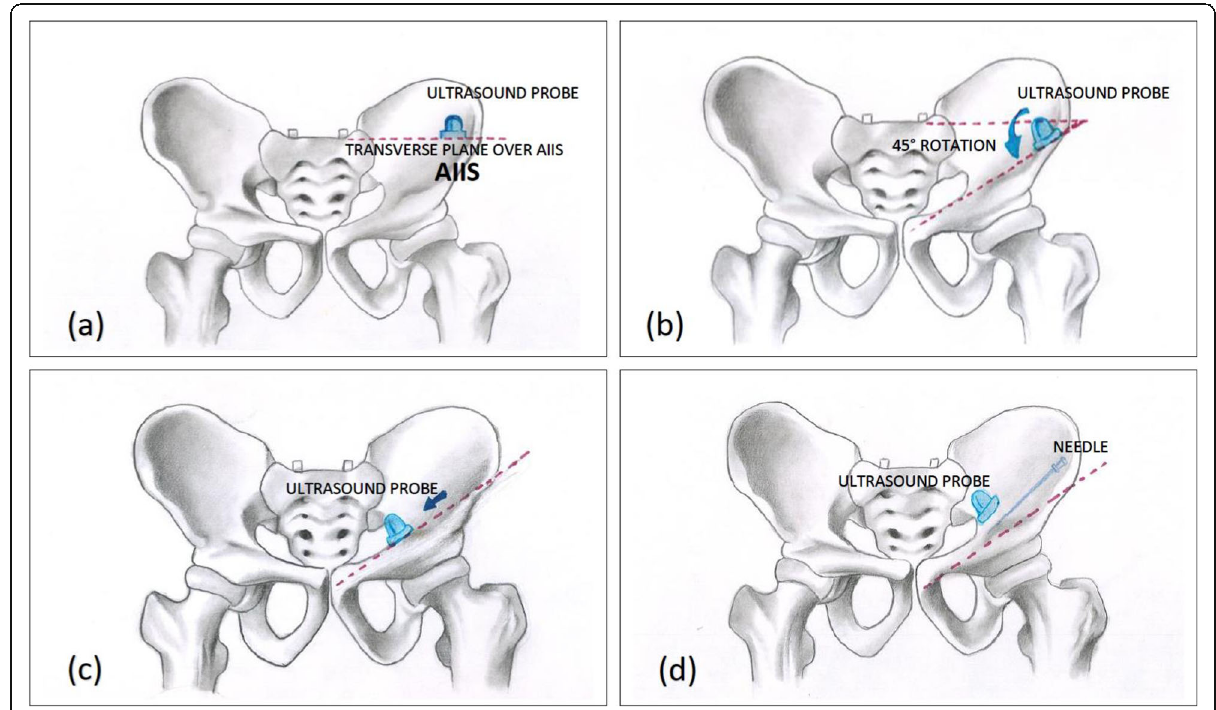
Fig. 3 Steps to perform PENG block as described by Giron et al. a Ultrasound probe is placed in a transverse plane over the AllS. b Ultrasound probe is then aligned with the pubic ramus by rotating the probe approximately 45° (clockwise and counterclockwise respectively in right and left side of the patient). c Ultrasound probe is then positioned to observe the IPE, the iliopsoas muscle and tendon, and the femoral artery. d The needle is inserted from lateral to medial in an in-plane approach to place the tip in the musculofascial plane between the psoas tendon anteriorly and the pubic ramus posteriorly. Abbreviations: AIIS, anterior inferior iliac spine, IPE, ilio-pubic